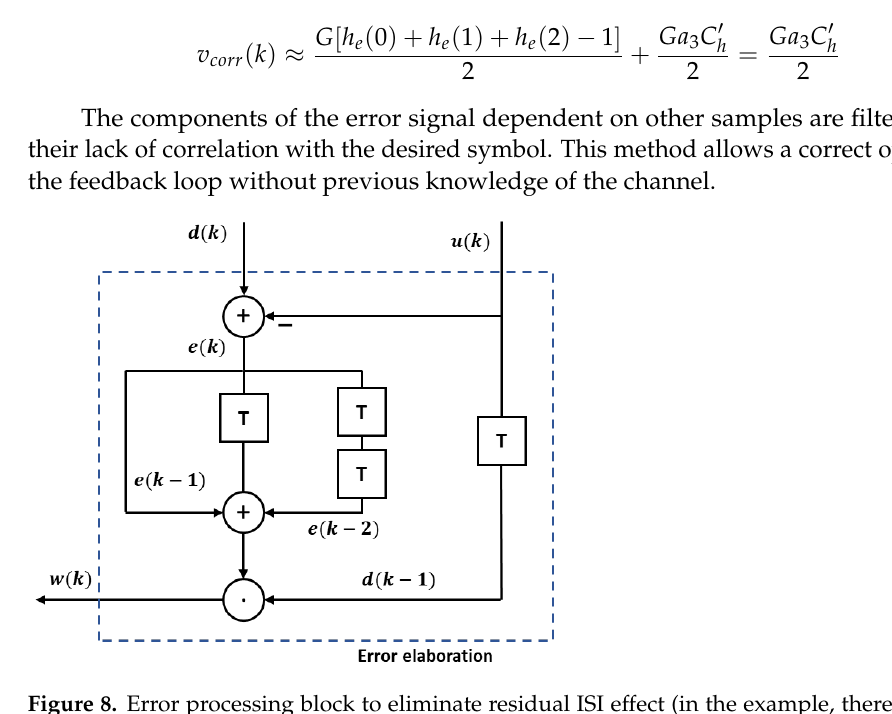
Figure 8. Error processing block to eliminate residual ISI effect (in the example, there is only one precursor and one post-cursor).